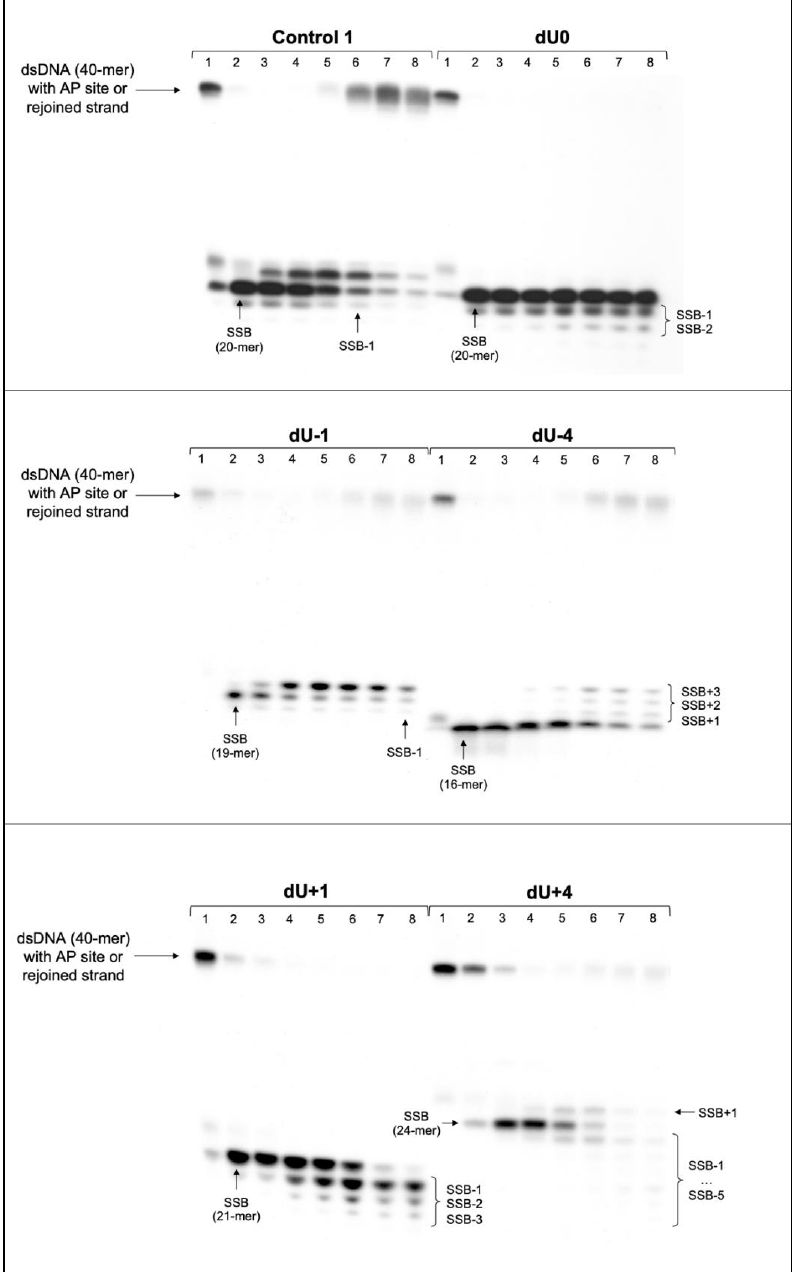
Figure 3. The exemplary autoradiogram of denaturing PAGE (cytoplasmic extract of xrs5 cells). The following protein activities can be observed: the endonucleolytic activity (bands denoted as SSB; dsDNA with single-strand break formed after strand incision by endonucleases), the polymerase activity (bands denoted as SSB+1, SSB+2, etc.; dsDNA with a single-strand break after incorporation of 1 or more undamaged nucleotides by polymerases), and exonucleolytic activity (SSB − 1, SSB − 2, etc.; dsDNA with a single-strand break after removal of 1 or more nucleotides by exonucleases). In some cases, strand rejoining is also observed, but it is not the focus of this article. Each lane corresponds to a different assay time: lane 1—0 min; lane 2—1 min; lane 3—5 min; lane 4—15 min; lane 5—30 min; lane 6—60 min; lane 7—90 min; and lane 8—120 min. Each experiment was performed three times for results consistency (individual replications, numerical data, and graphical representation of results with SD are available in Supplementary